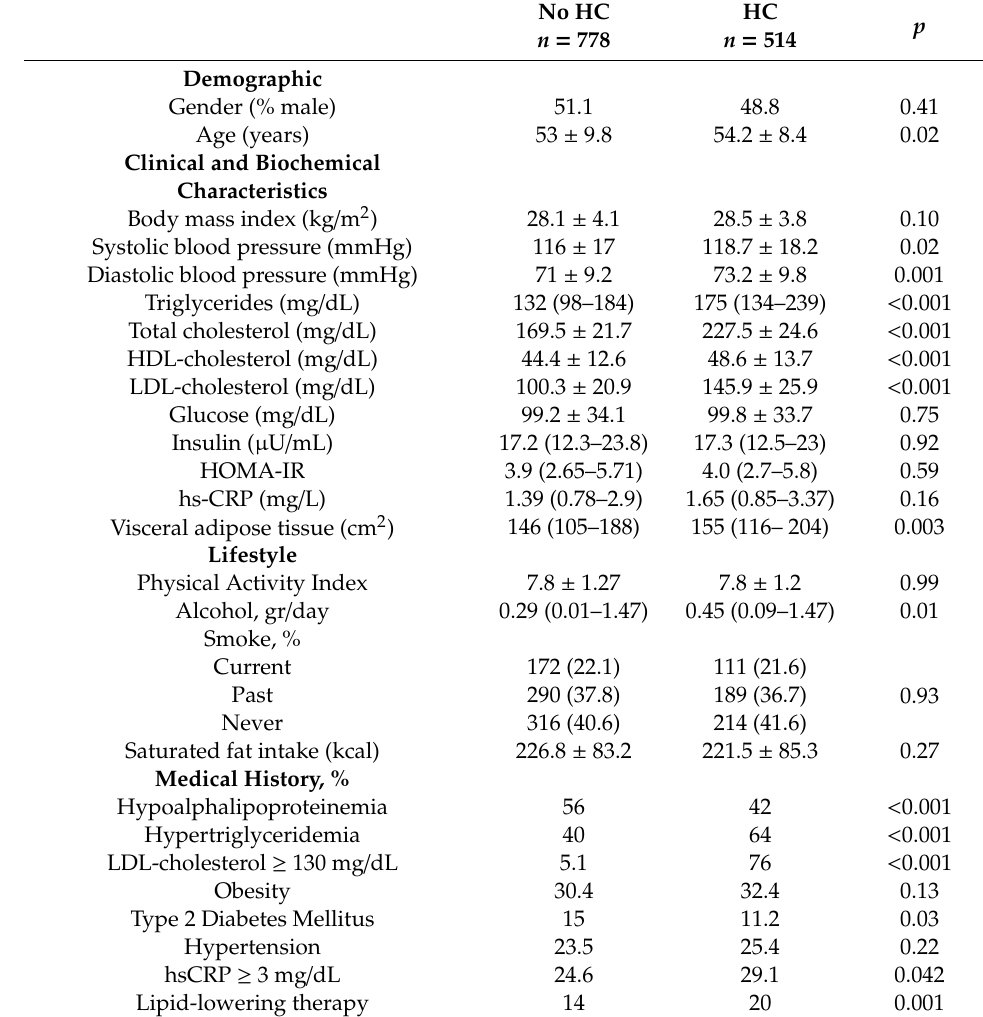
Table 1. Characteristics of the study